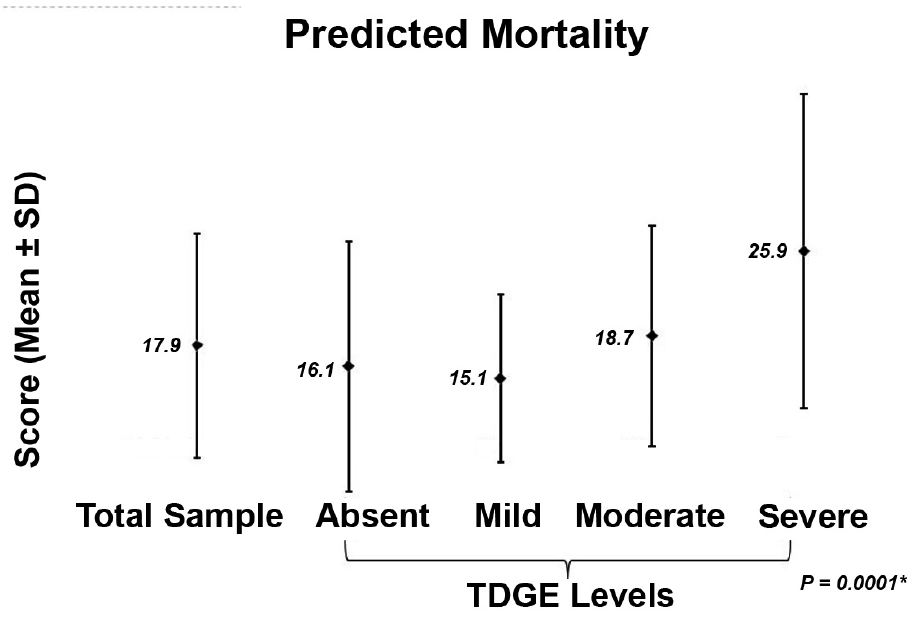
Fig. 2 - Mortality predicted by APACHE II. TDGE=transient dysfunction of gas exchange; TDGE absent=PaO FiO between 200 mmHg and 300 mmHg; TDGE moderate=PaO 2 severe TDGE=PaO /FiO <100 mmHg; * P-value: ANOVA followed by transformation with posts by 2 2 Tukey’s test. TDGE Record significantly proved superior to other levels of TDGE regarding